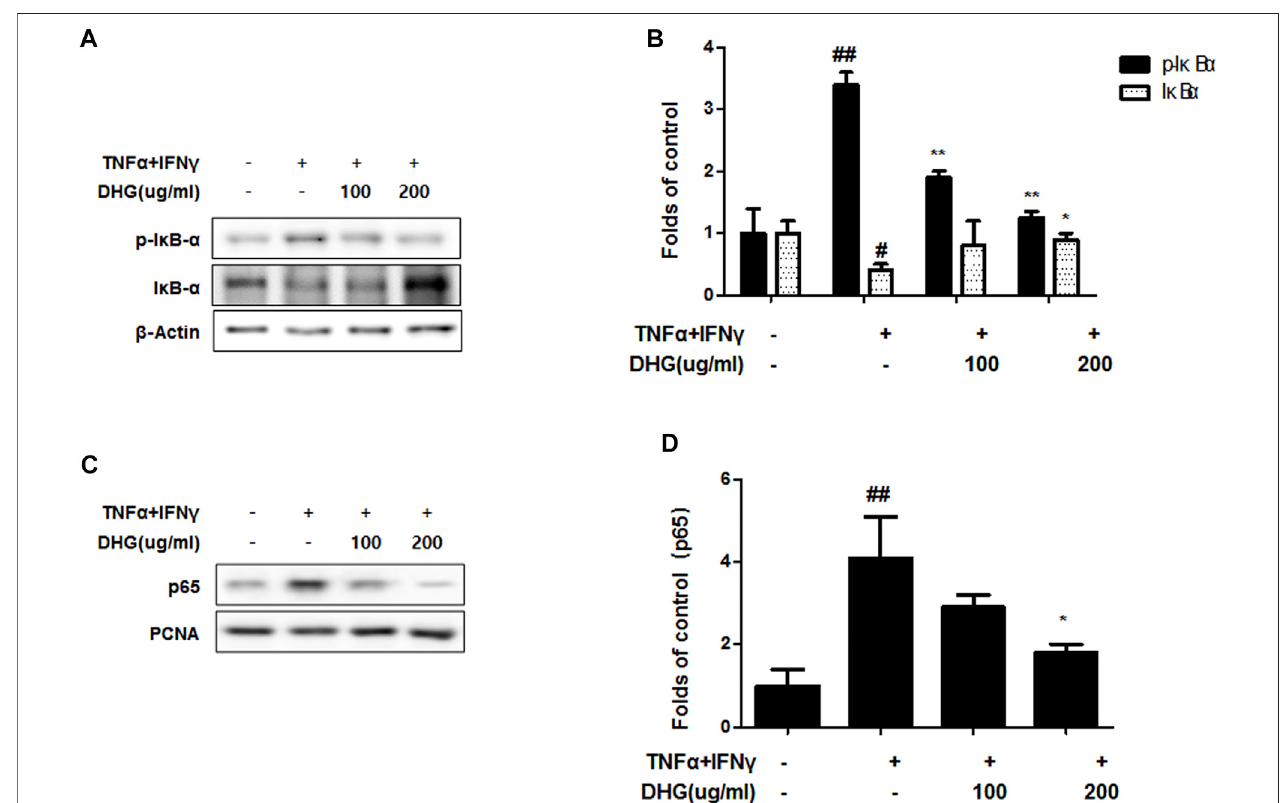
FIGURE 9 | Effects of DHG on NF- κ B activation (A — D) in TNF- α /IFN- γ stimulated HaCaT cells. The cells were pre-treated with the indicated concentrations of DHGfor3 handthenstimulatedwithTNF- α /IFN- γ (each10 ng/ml)for15 min.Cytosolandnuclearextractswereisolated,andlevelsofp65,p-I κ B α andI κ B α infractions were determined by western blotting. Total proteins were prepared and were determined by western blotting. The bar graphs represent quantitative densities of the bands. Data are represented as mean ± SD of three independent experiments. * p < 0.05, ** p < 0.01 compared with the TNF- α /IFN- γ -treated